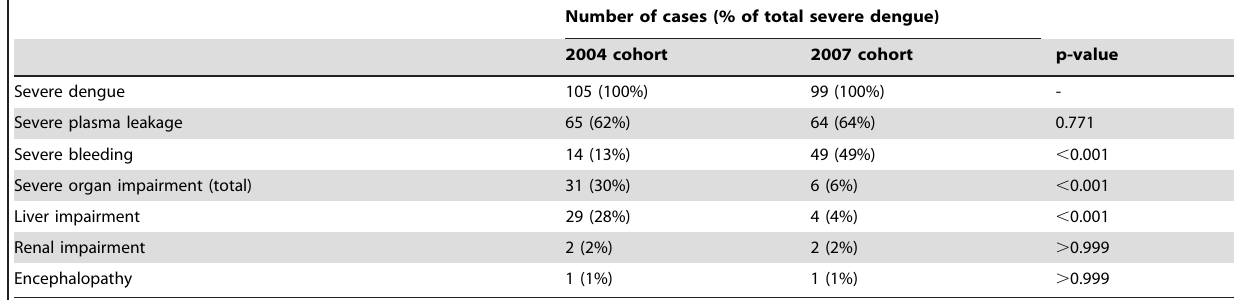
Table 4. Manifestations of severe dengue in 2004 vs 2007